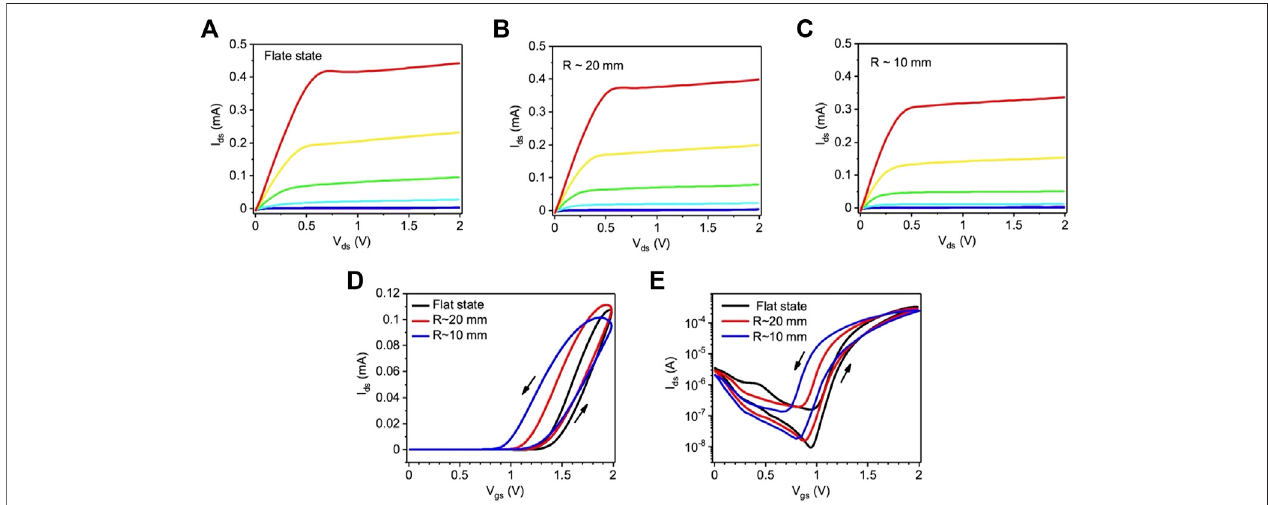
FIGURE 5 | (A – C) Output and (D,E) transfer characteristics of route II TiO 2 fi lms on PET substrates gated with [EMIM] [TFSI] measured in a N 2 purged glove box. The output characteristics under (A) fl at, (B) bending radius ~20 mm and (C) bending radius ~10 mm were measured at V gs = 0, 1.0, 1.25, 1.5, 1.75, and 2.0 V. The transfer characteristics under fl at and bent state were measured in (D) linear (V ds = 0.2 V) and (E) saturation (V ds = 1.75 V) regime. The scan rate is 50